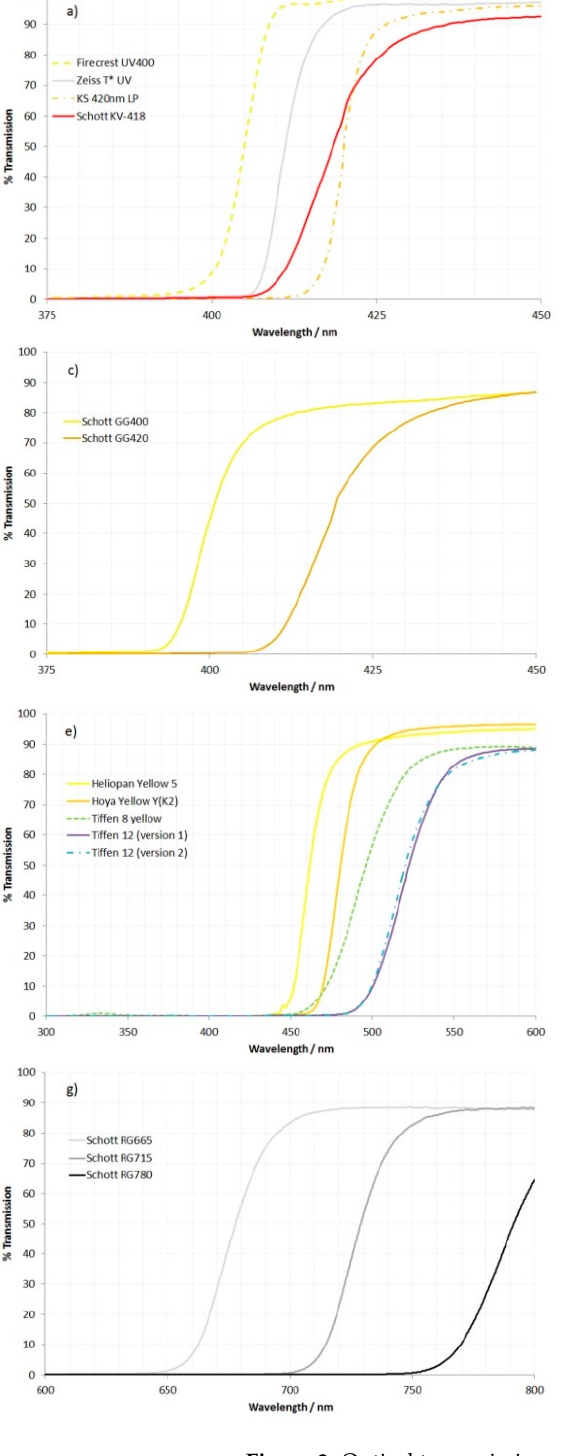
Figure 3. Optical transmission spectra of the test filters: ( a ) Firecrest UV400, Schott KV-418, Zeiss T* UV and KS 420 nm LP from 375 nm to 450 nm; ( b ) Firecrest UV400, Schott KV-418, Zeiss T* UV and KS 420 nm LP extended range from 350 nm to 800 nm; ( c ) Schott GG400 and GG420 from 375 nm to 450 nm; ( d ) Schott GG400 and GG420 from 350 nm to 800 nm; ( e ) Heliopan Yellow 5, Hoya Yellow Y(K2), Tiffen Yellow 8, Tiffen Yellow 12 (version 1 and 2) from 300 nm to 600 nm; ( f ) B + W 486 UV/IR cut and Baader UV/IR cut from 300 nm to 800 nm; ( g ) Schott RG665, RG715 and RG780 from 600 nm to 800 nm; ( h ) Quaser 415 nm 1%, 476 nm 1%, 510 nm 1%, 549 nm 1%, 593 nm 1% from 300 nm to 700 nm.